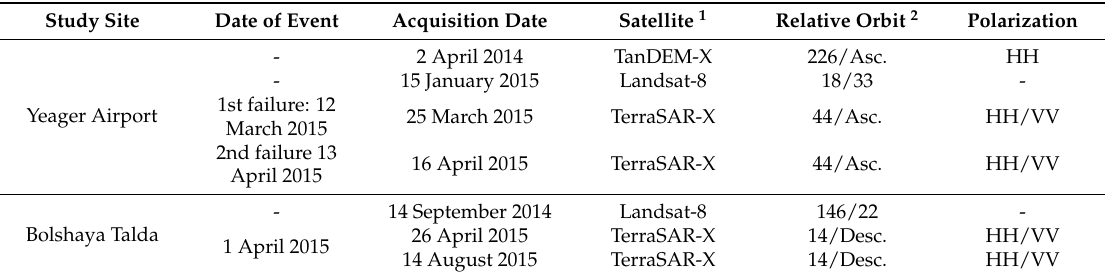
Table 1. Timeline of the landslide events and used satellite